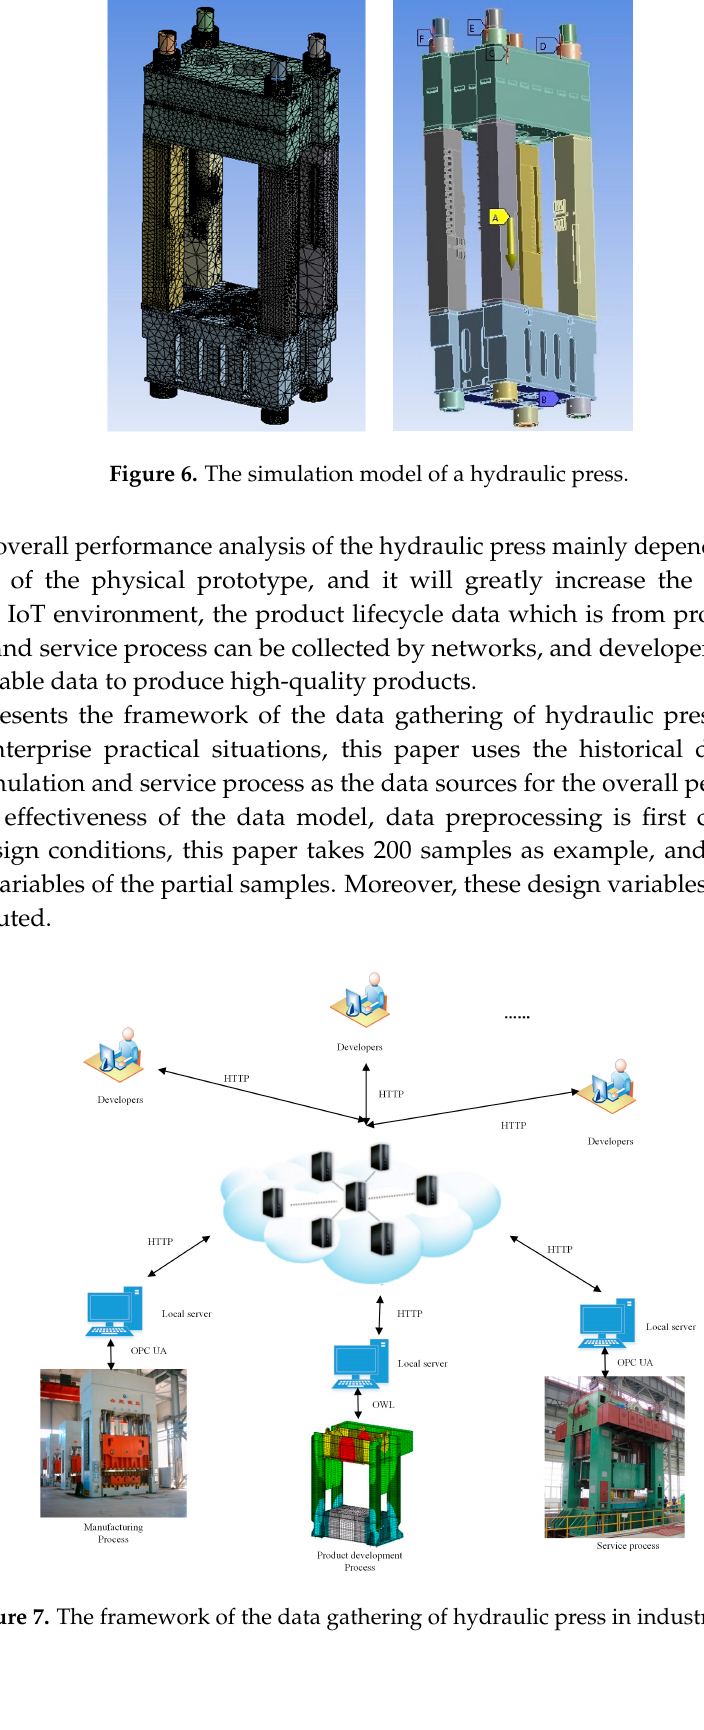
Figure 7. The framework of the data gathering of hydraulic press in industrial IoT.